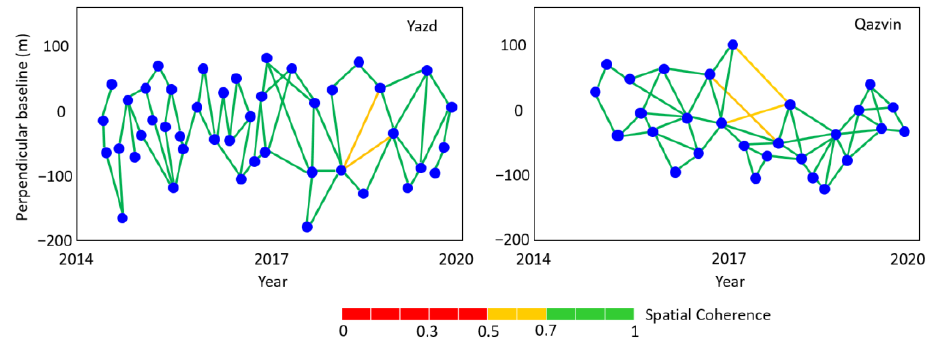
Figure 7. Interferograms visualized in the perpendicular and temporal baseline .